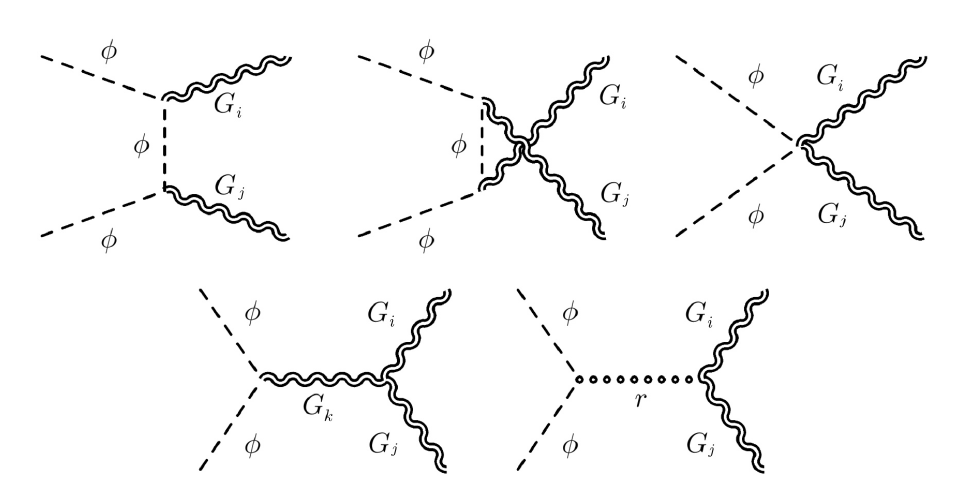
Figure 4 . Feynman diagrams contributing to φφ −→ G i G j